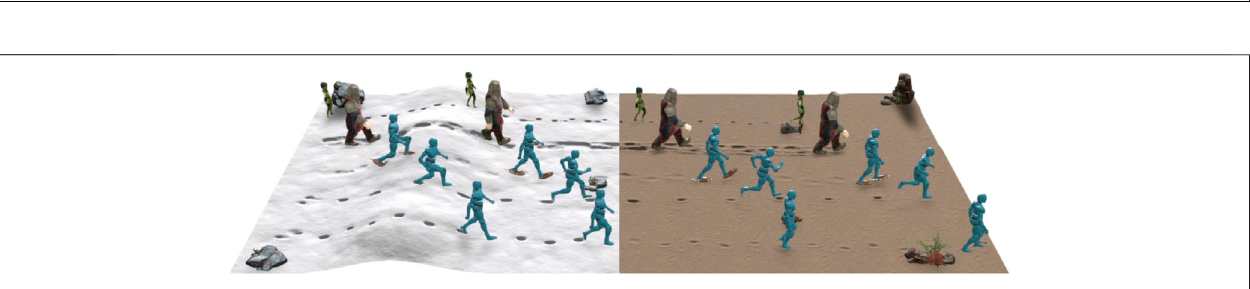
FIGURE3| Left: compressivemodelofthe terrain using Hooke ’ slaw.Each cellin contact withthe foot isrepresented byacompressible cylinder ofinitial length L 0 and Young ’ s modulus E . Right: 2D grid generation and contact area for each foot.